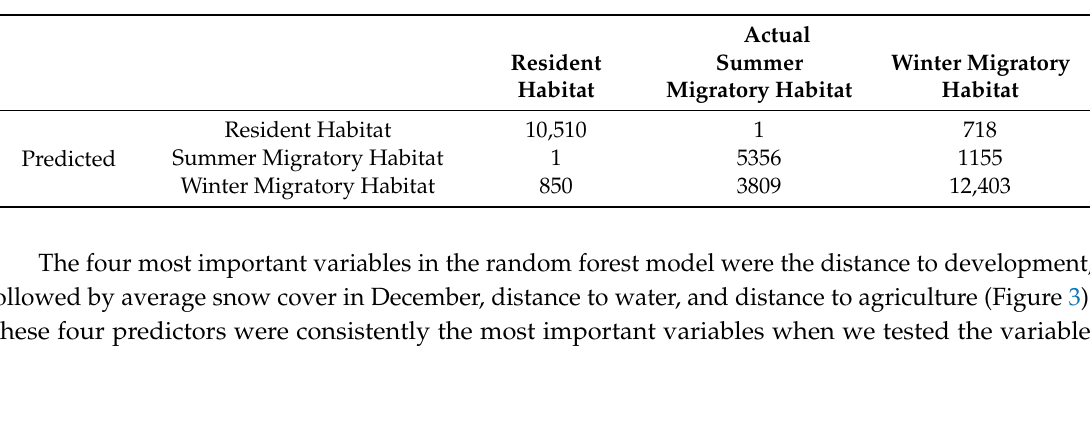
Table 2. Confusion matrix of cross-validation relocation data showing the number of instances that the random forest correctly and incorrectly classified GPS data, where the reference is the actual habitat type and the estimation column is how the model classified the